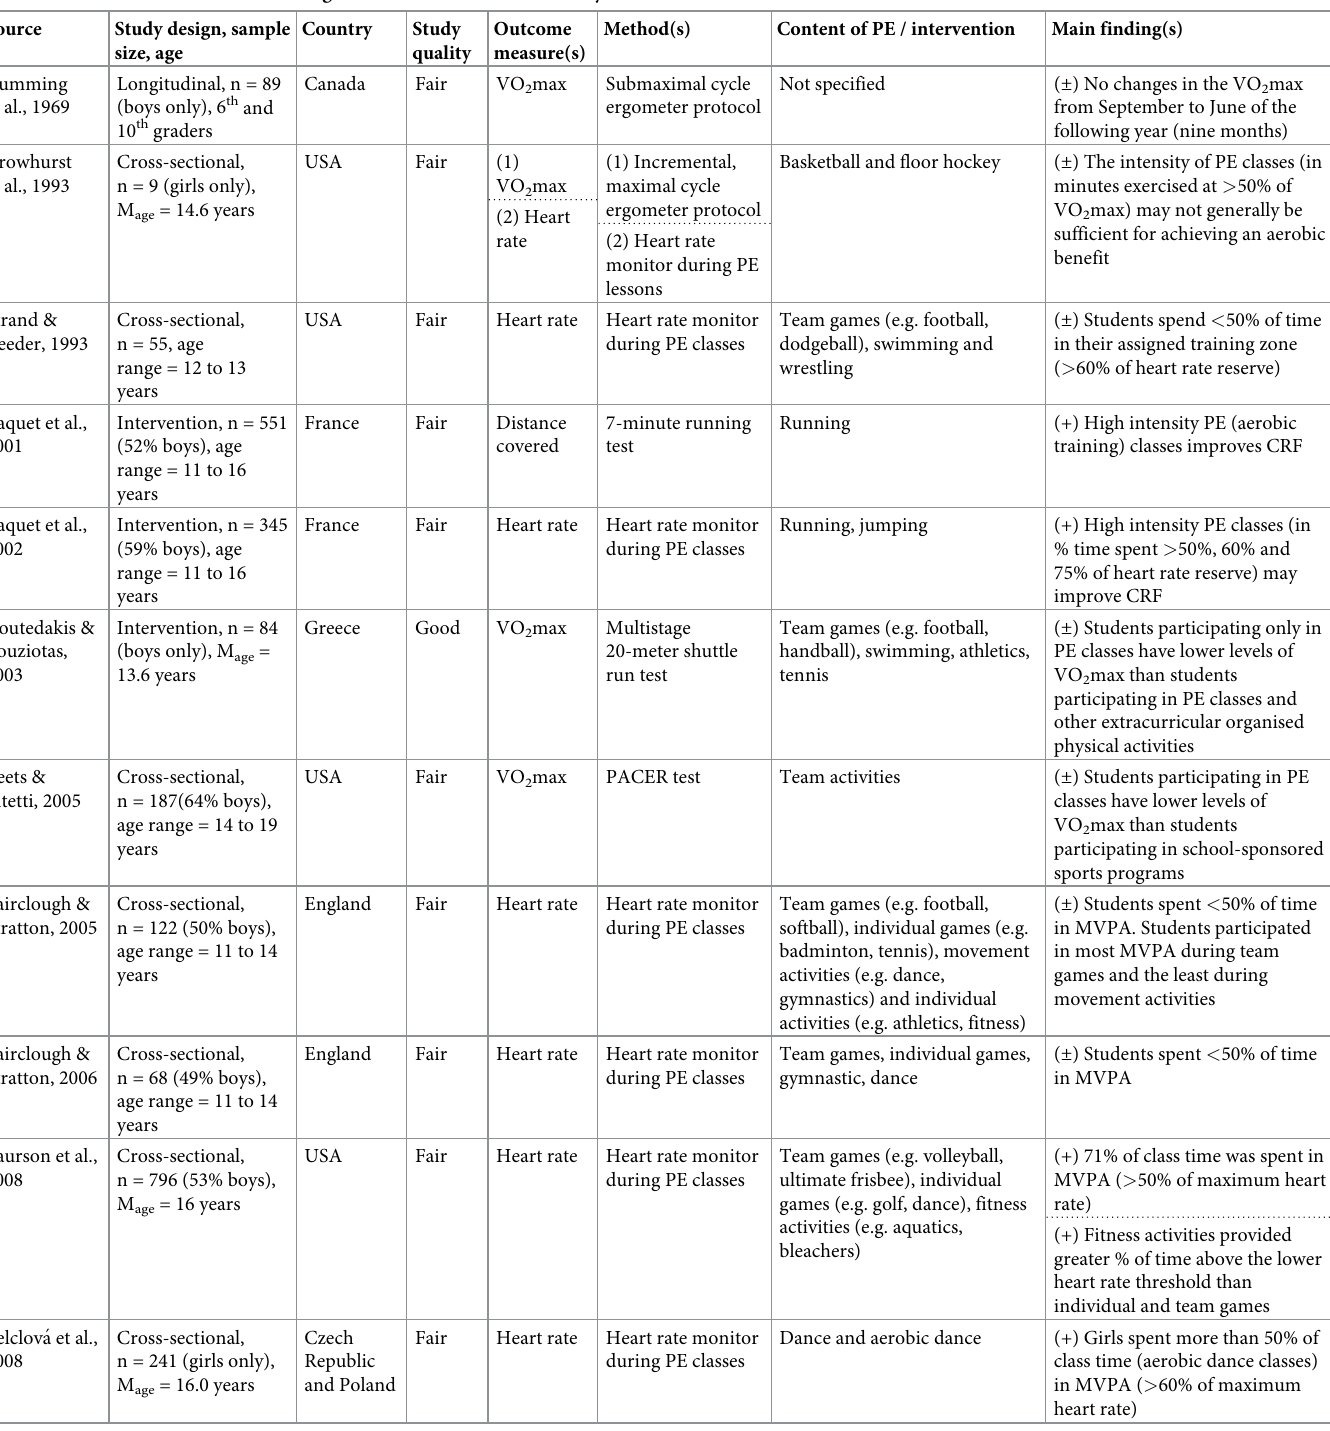
Table 3. Characteristics and main findings of the studies included in the systematic